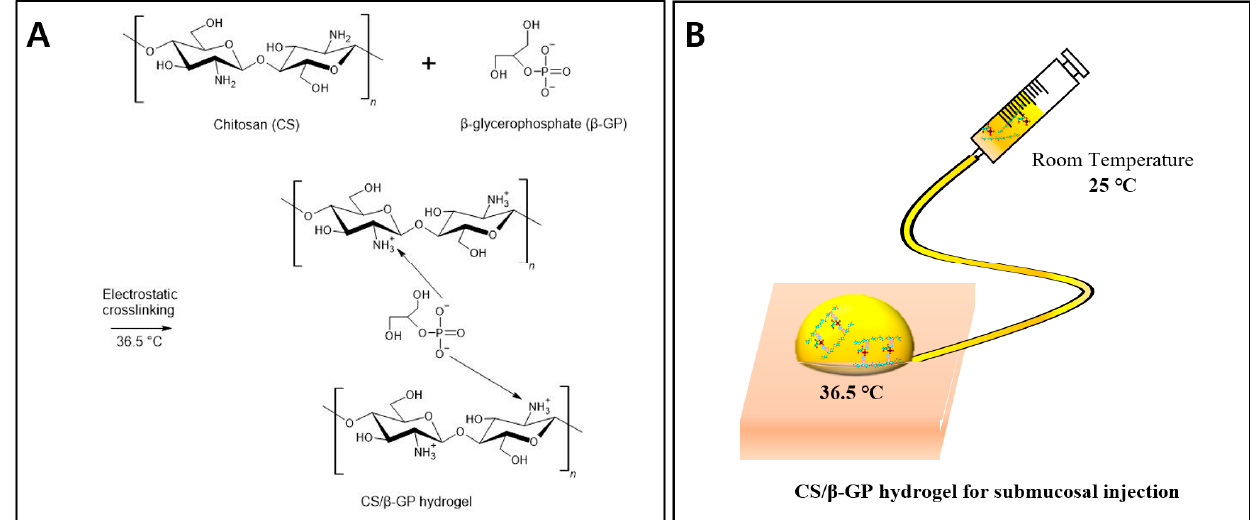
Figure 1. The schematic illustration of this study. ( A ) Chemical scheme of the reaction. Injectable thermosensitive chitosan (CS) solution with β -glycerophosphate ( β -GP) produces CS/ β -GP hydrogel at 36.5 °C. ( B ) Injectable thermosensitive chitosan solution at room temperature turns into a viscous hydrogel in the submucosa of the body resulting in submucosal fluid cushion (SFC) for endoscopic submucosal dissection (ESD).